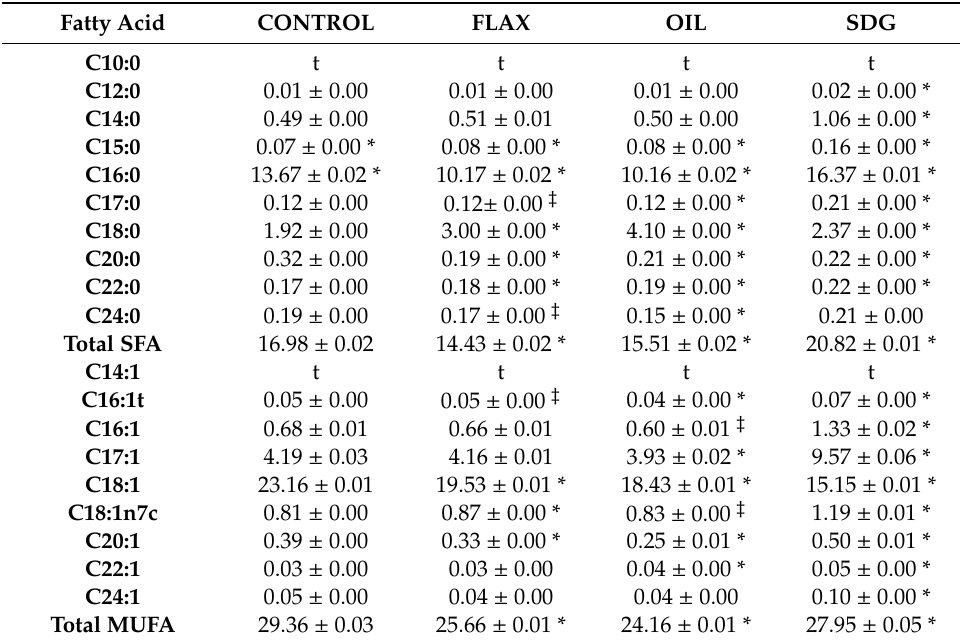
Figure 1. Effect of flaxseed supplementation in the diets. ( A ) ALA (C18:3n3) levels. ( B ) Sum of n-3 fatty acids ( ∑ n-3) levels. ( C ) Ratio of n-6 and n-3 fatty acids ( ∑ n-6/n-3) levels. Data are presented as mean ± SD, ( n = 3). **** Significantly different from the control diet, p < 0.0001. ALA, alpha-linolenic acid; FLAX, chow diet supplemented with 10% ground flaxseed; OIL, chow diet supplemented with 4.4% ALA enriched flax oil; SDG, chow diet supplemented with 0.44% secoisolariciresinol diglucoside. Table 1. Dietary fatty acid analysis.